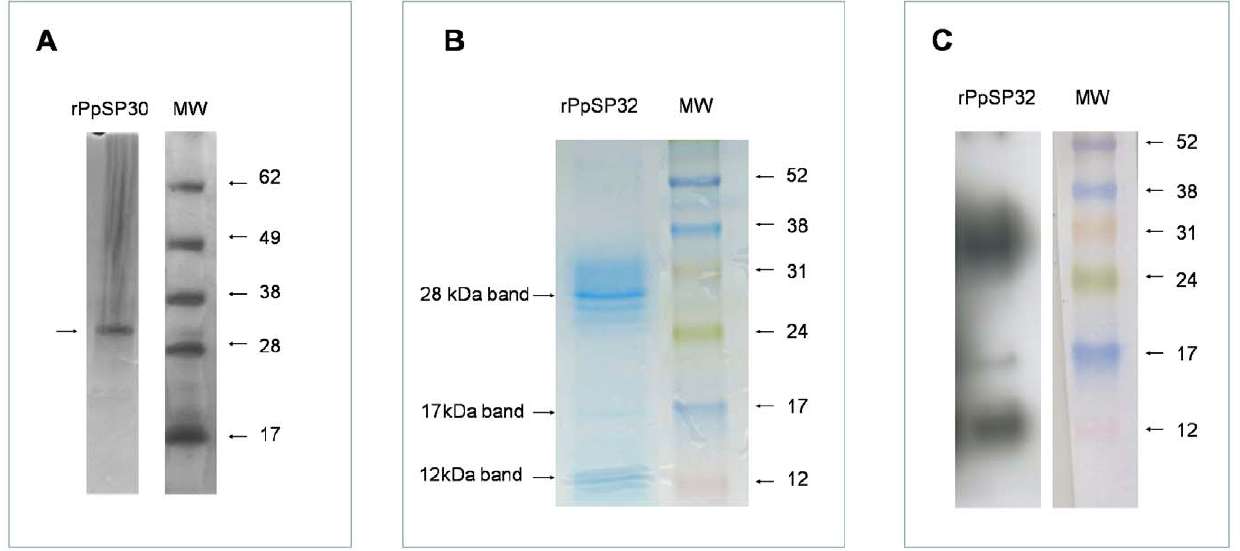
Figure 4. Staining of the recombinant proteins. ( A ) Silver-stained SDS-PAGE gel of recombinant protein rPpSP30. ( B ) Commassie blue-stained SDS-PAGE gel of recombinant protein rPpSP32. ( C ) Western blot analysis of rPpSP32 using monoclonal anti-polyhistidine antibody.